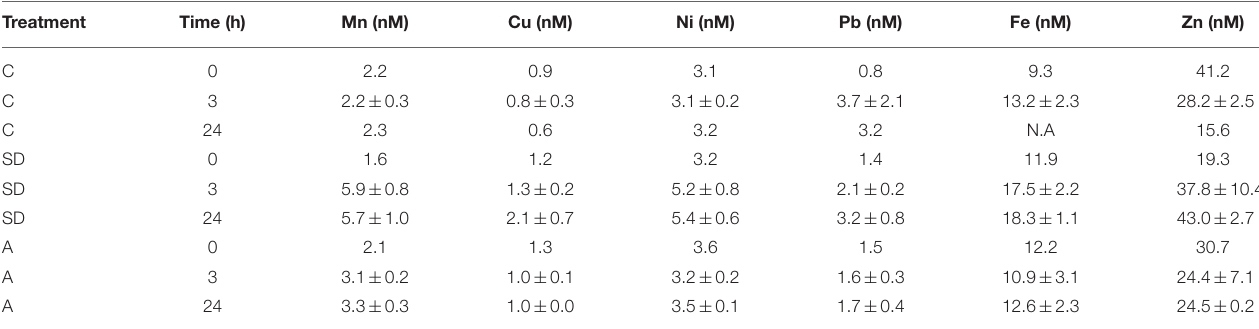
TABLE 4 | Summary of the trace metal concentrations in the different mesocosms 24h after the SD or A additions.